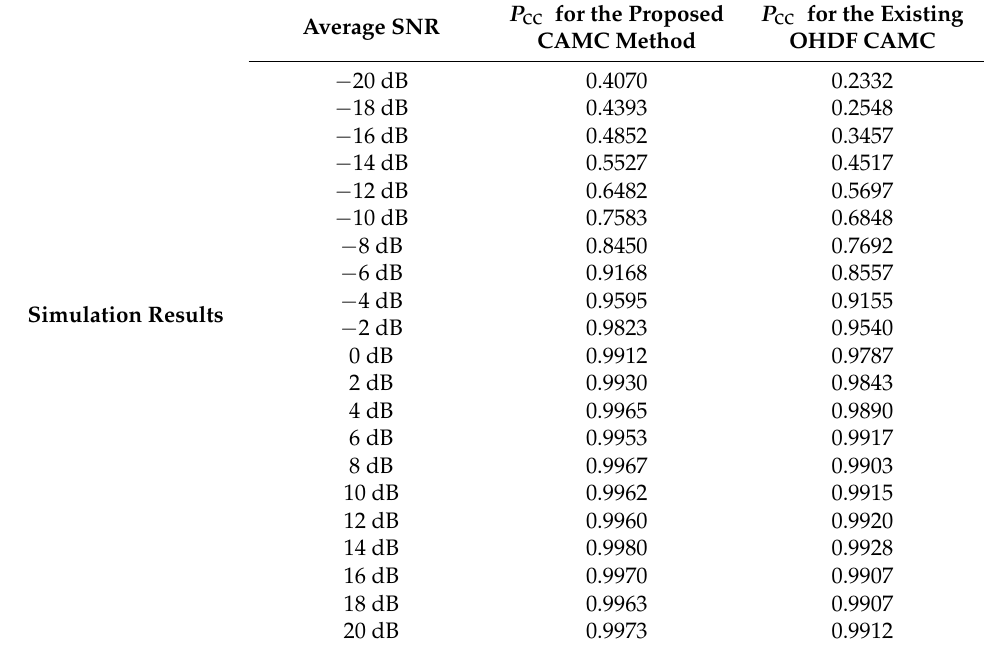
New Scheme Graph-based AMC Method